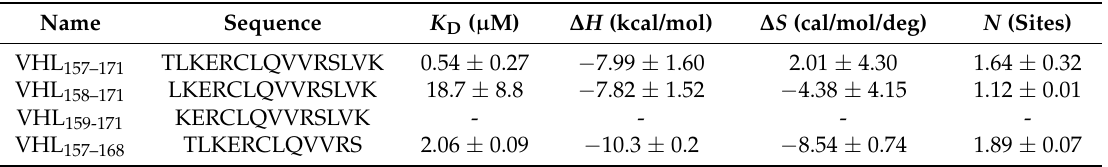
Figure 4. ( A ) Isothemal titration caloritetry (ITC) thermograms of elongin BC with various kinds of peptides. Results of ITC experiments by titrating elongin BC with VHL peptides are shown. The panels represent raw ITC data. Sequences of peptides used are shown in the corresponding thermograms. ( B ) Structure of elongin BC and VHL complex (PDB ID 4WQO). Elongin B, elongin C, and VHL are colored green, pink, and cyan, respectively. N-terminal residues of the BC-box of VHL are highlighted as cyan sticks and some relevant residues of elongin C are shown by pink sticks. Blue, red, and yellow represent nitrogen, oxygen, and sulfur atoms, respectively. Table 2. Equilibrium dissociation constants and thermodynamic parameters determined by ITC assays.